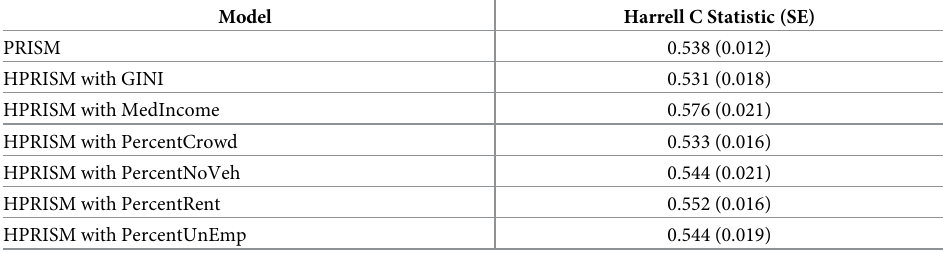
Table 4. Test set prediction performance of the various